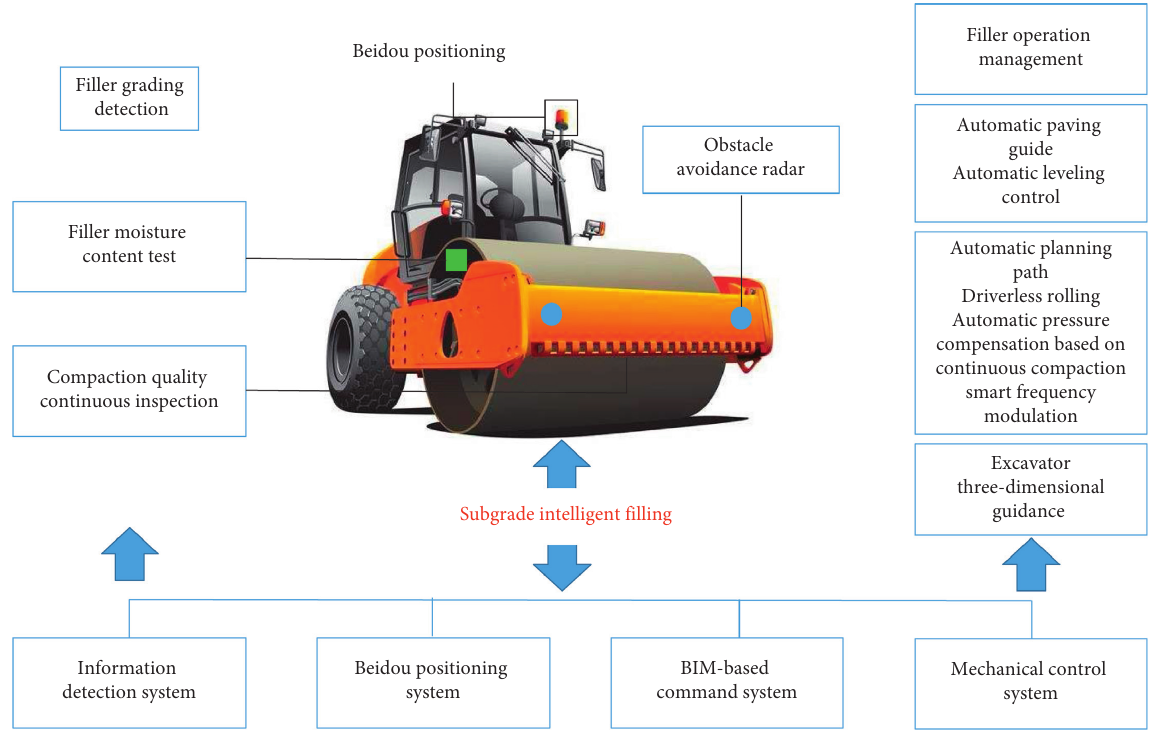
Figure 1: Schematic diagram of the intelligent road roller in the Gu’an section of Beijing-Xiong’an Railway.